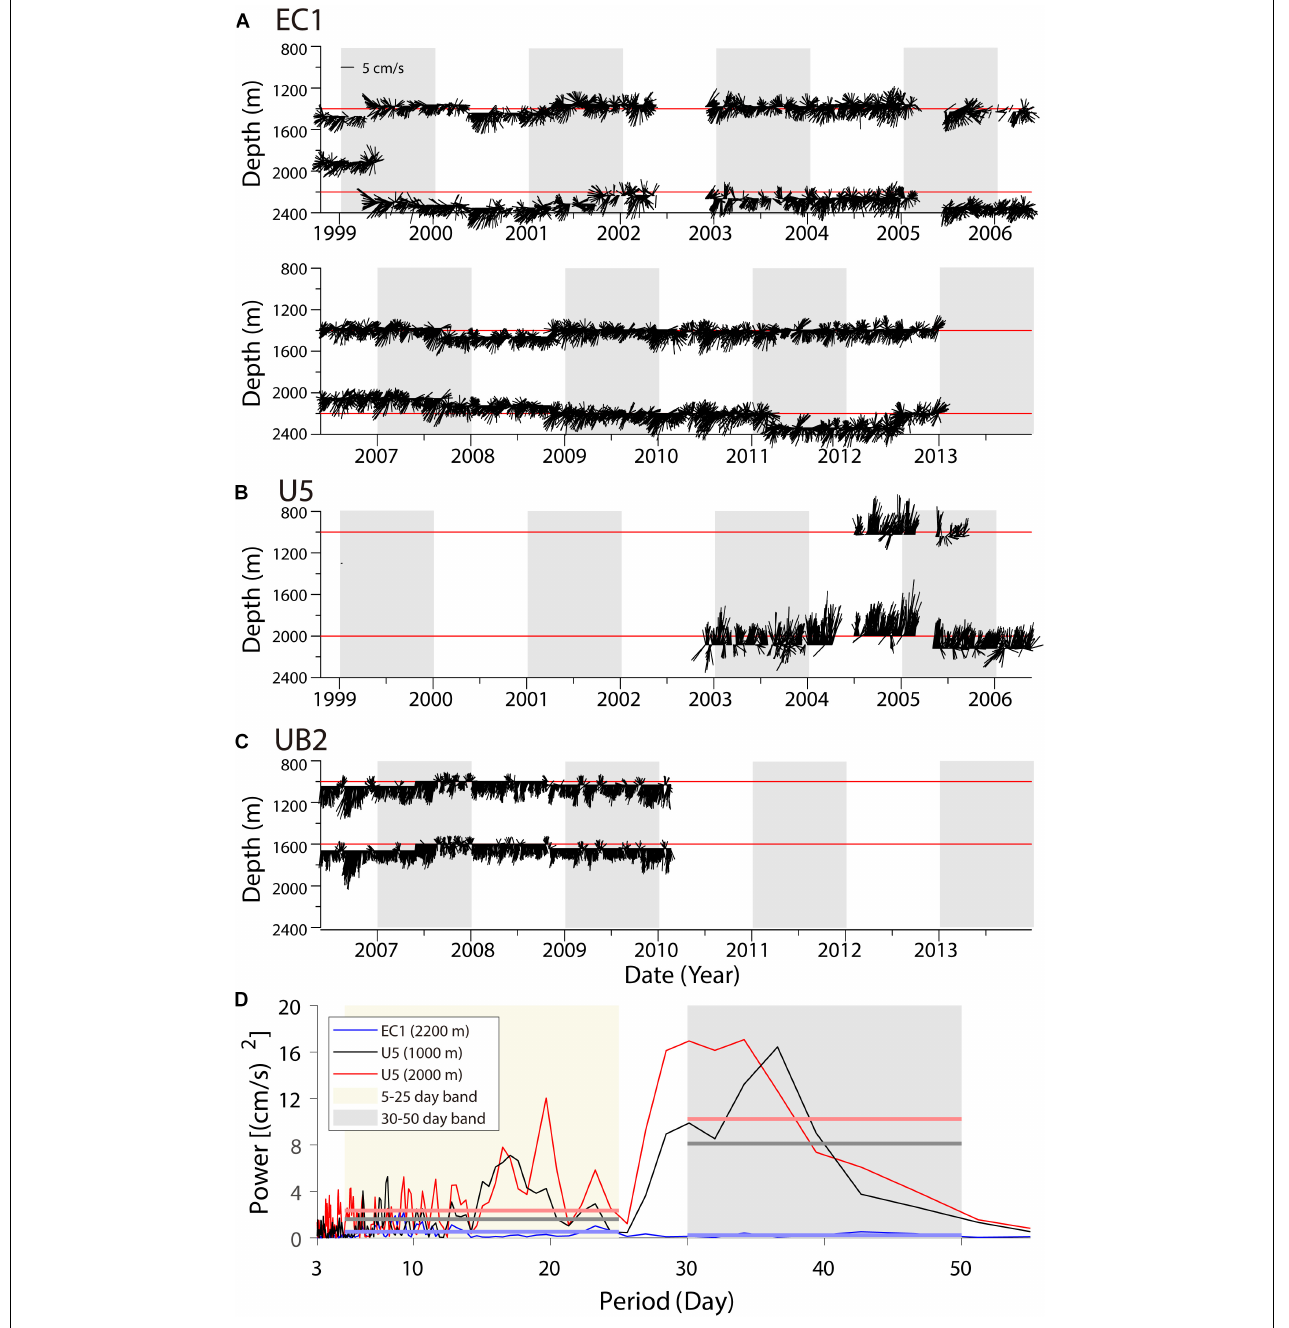
FIGURE 3 | Time series of daily mean currents observed at (A) EC1, (B) , U5, and (C) UB. The horizontal red bars denote the nominal depth. (D) Total kinetic energy spectra of EC1 (blue) and 1000 and 2000 m of U5 (black and red), in variance-preserving form of currents observed at 1000 m of U5 from July 2004 to September 2005. The horizontal bars refer to the mean spectral energy for shorter and longer intraseasonal bands